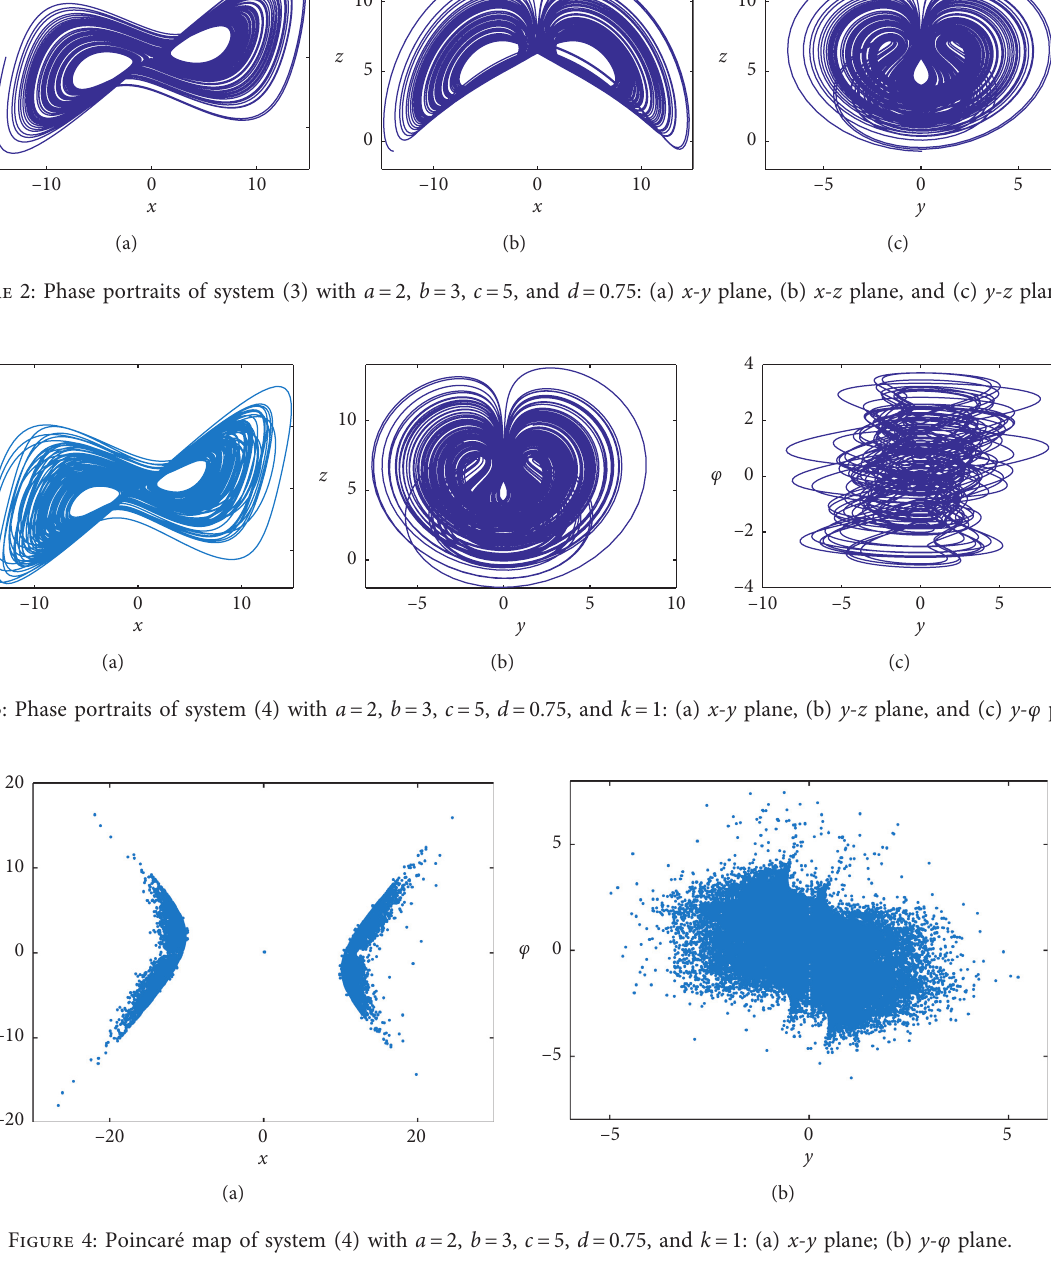
Figure 4: Poincar´e map of system (4) with a � 2, b � 3, c � 5, d � 0.75, and k � 1: (a) x - y plane; (b) y - φ